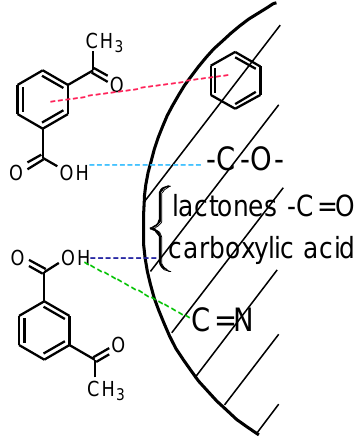
Figure 12. Proposal mechanism of sorption.